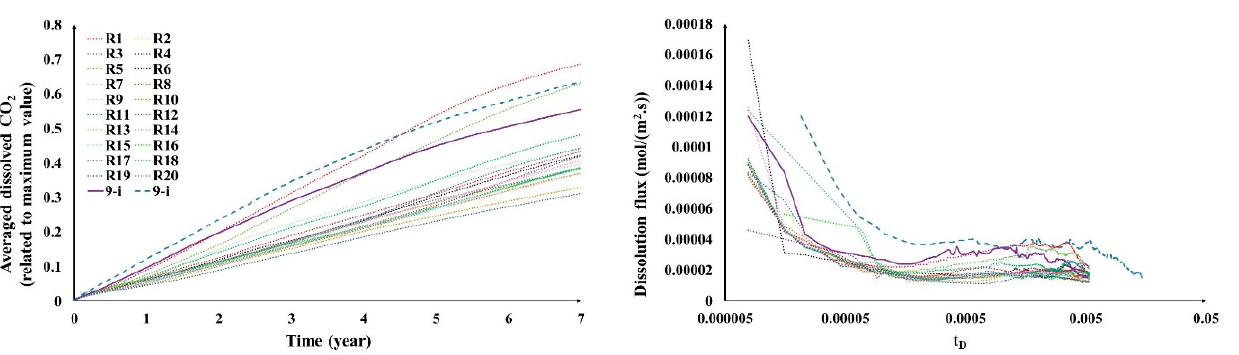
Figure 11. The heterogeneous realizations (dotted lines), homogeneous with considering cross-diffusion (solid line), and homogeneous without considering cross-diffusion (dashed line) averaged dissolved CO 2 and dissolution flux for case 9-i. Legends for left- and right-hand subplots are same.